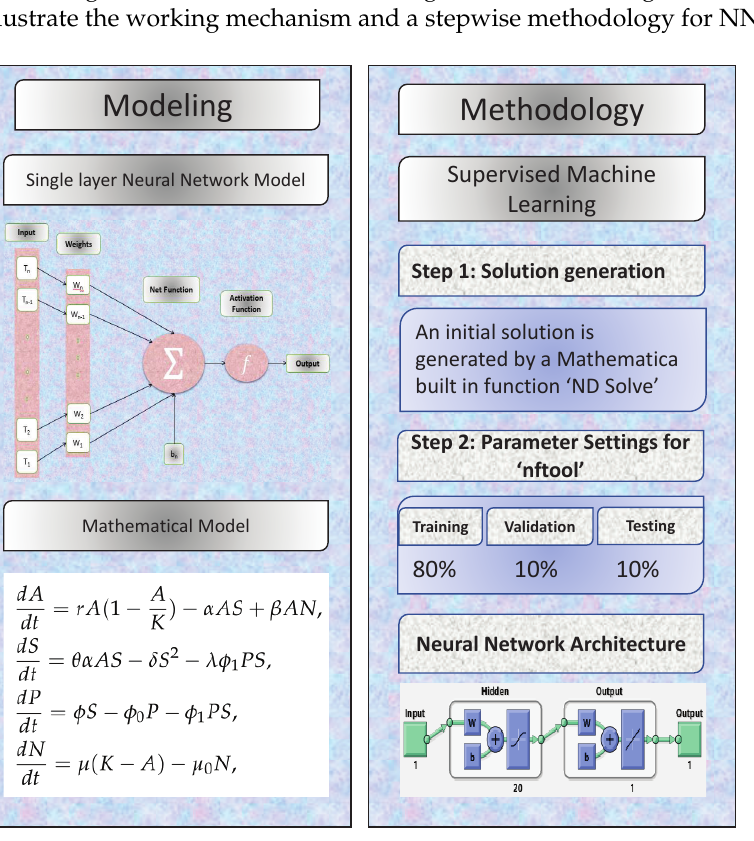
Figure 2. The NNs–LM method for a mathematical model